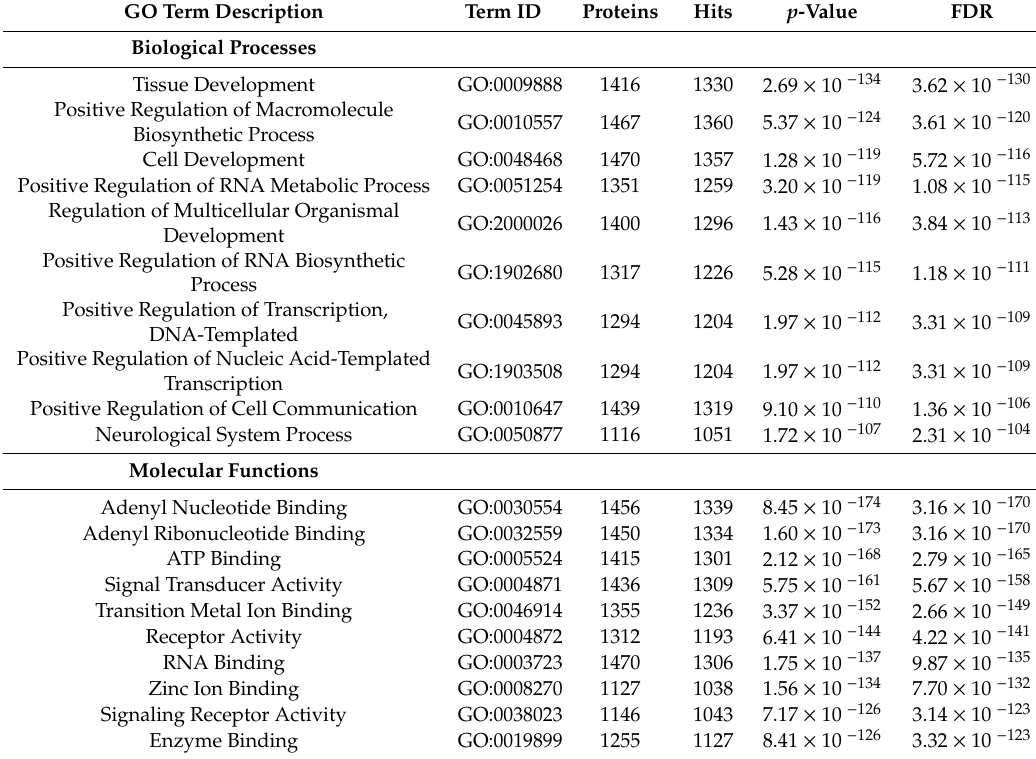
Table 2. Gene ontology